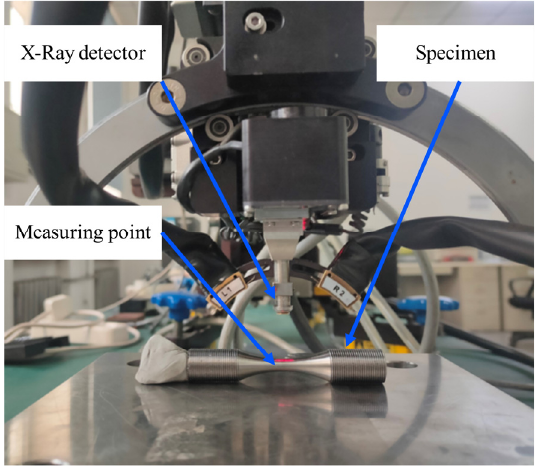
Figure 2. X-ray diffraction stress meter and residual stress measuring point.